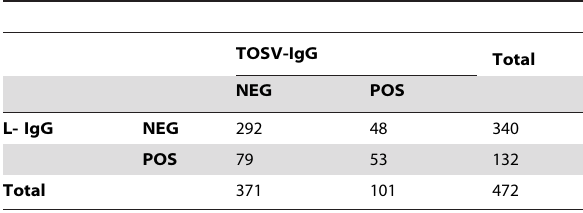
Table 1. Results of serological analysis for Leishmania parasite and Toscana